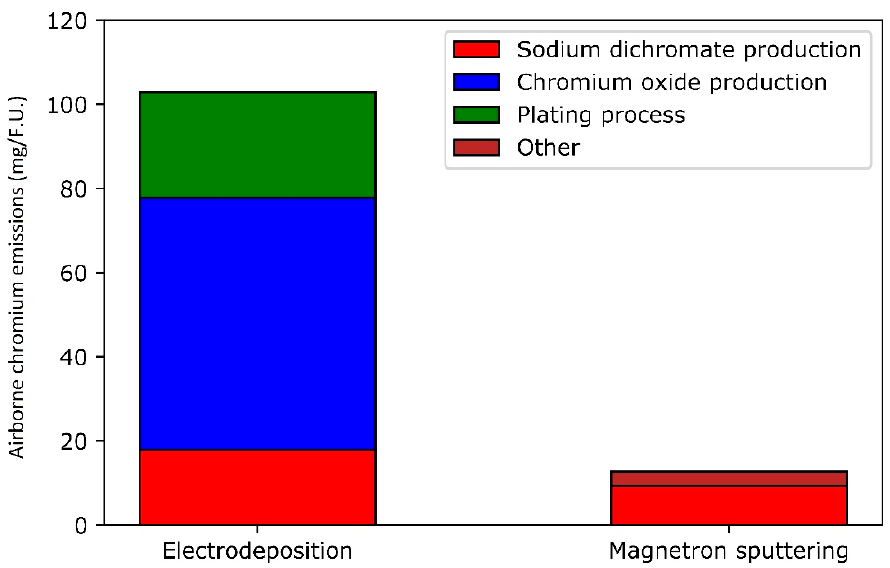
Figure 5. Hexavalent chromium airborne emissions.